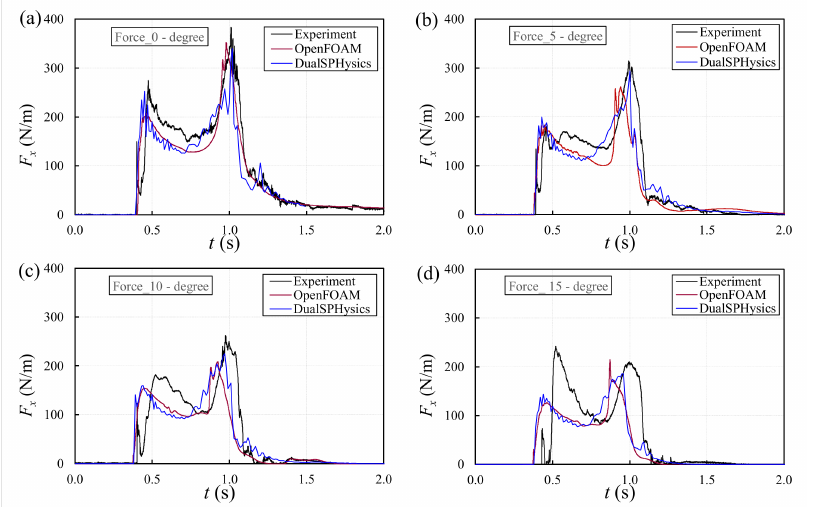
Figure 9. Comparison of the time-history of the impact force on the vertical wall from experiment and numerical simulations using the OpenFOAM and DualSPHysics models: ( a ) 0-degree case; ( b ) 5-degree case; ( c ) 10-degree case; ( d ) 15-degree